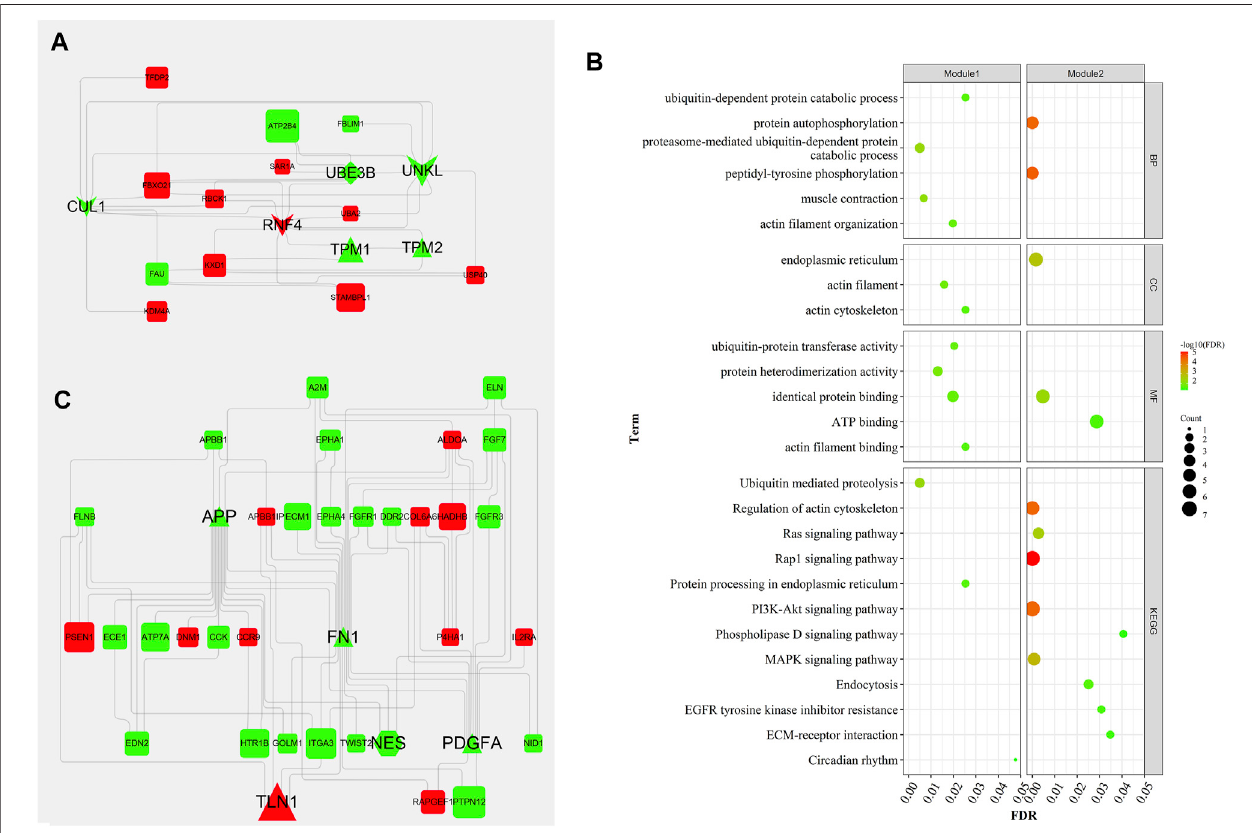
FIGURE 4 | Two hub modules from the PPI network and their enrichment analysis. Module 1 (MCODE score (cid:1) 4.353), including 18 nodes and 37 edges (A) , and module 2 (MCODE score (cid:1) 3.771), containing 36 nodes and 66 edges ( C ), were constructed from the PPI network of the DEGs using MCODE. The color and shape represent the same values asdescribed in Figure 2 . The seed nodes in modules 1 and 2 were RNF4 and FN1, respectively. (B) represent the bubble diagrams for gene enrichmentinmodules 1and 2,respectively.Thecolorand sizeofthedotrepresentthenumber ofenriched genesand themagnitude ofsigni fi